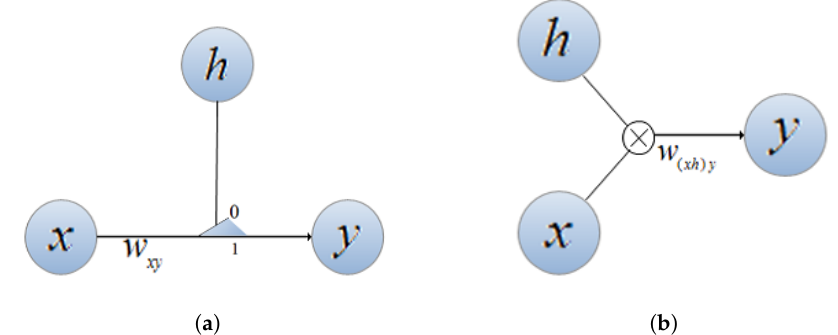
Figure 1. Two types of gating connections. ( a ): gated connection used to control the flow of information in a network; ( b ): gated connection implementing a multiplicative relationship between two inputs x and h to provide the output y